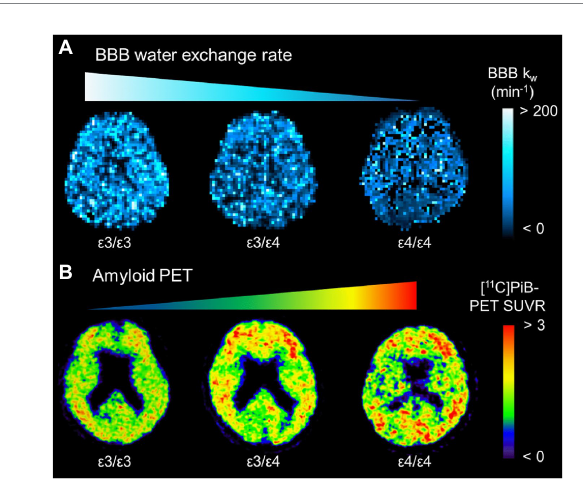
FIGURE 2 Representative BBB k w map (A) and [ 11 C]PiB-PET SUVR (B) from an APOE ɛ 4 noncarrier ( ε 3/ ε 3 ), a heterozygote ( ε 3/ ε 4 ), and a homozygote ( ε 4/ ε 4 ). The k w map from the homozygote ( ε 4/ ε 4 ) displays the lowest k w values, which are associated with the highest SUVRs of [ 11 C]PiB-PET. APOE : apolipoprotein E; BBB, blood–brain barrier; PiB, Pittsburgh compound B; SUVR, standard uptake value ratio [adapted with permission from Uchida et al. (2022a)].